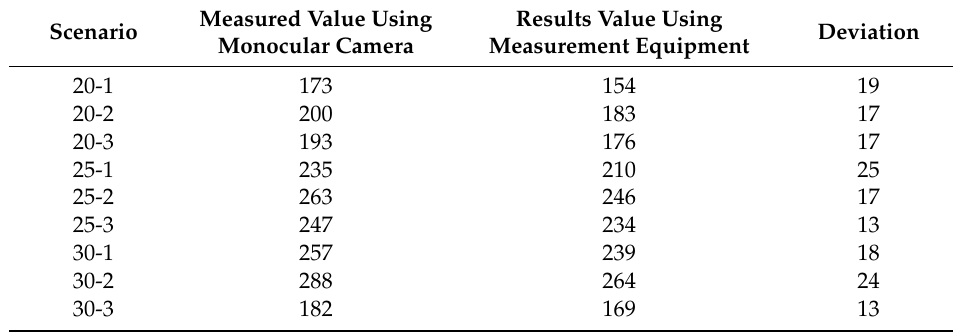
Table 9. Error factor by scenario of measured value using monocular camera vs results value using measurement equipment (CPNA),